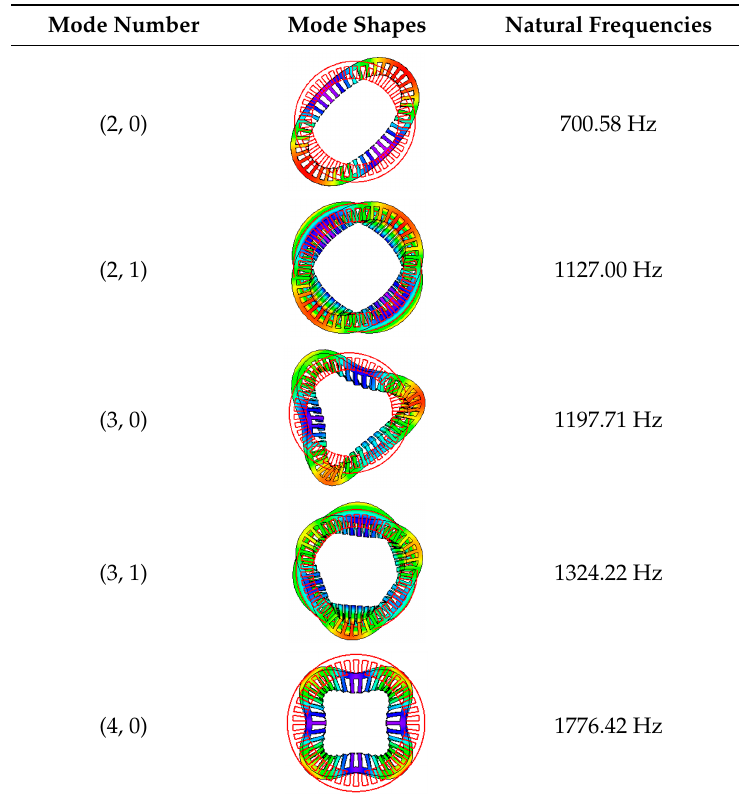
Table 4. Modal shapes and frequencies.